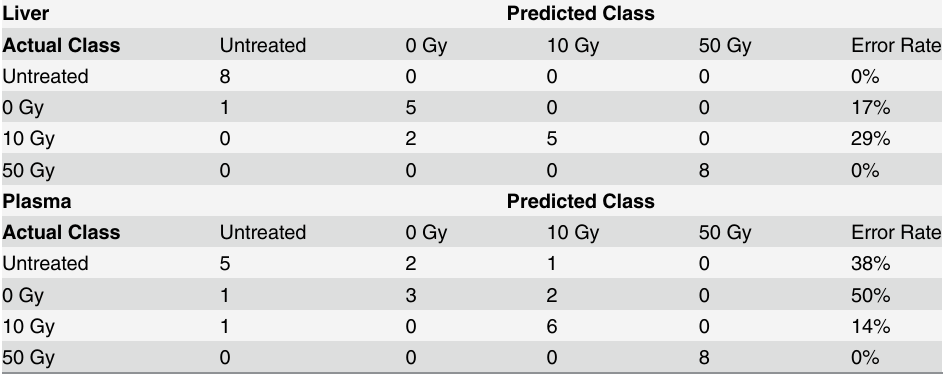
Table 3. The Random Forest classifier correctly classifies almost 90% of liver and 76% of plasma samples.